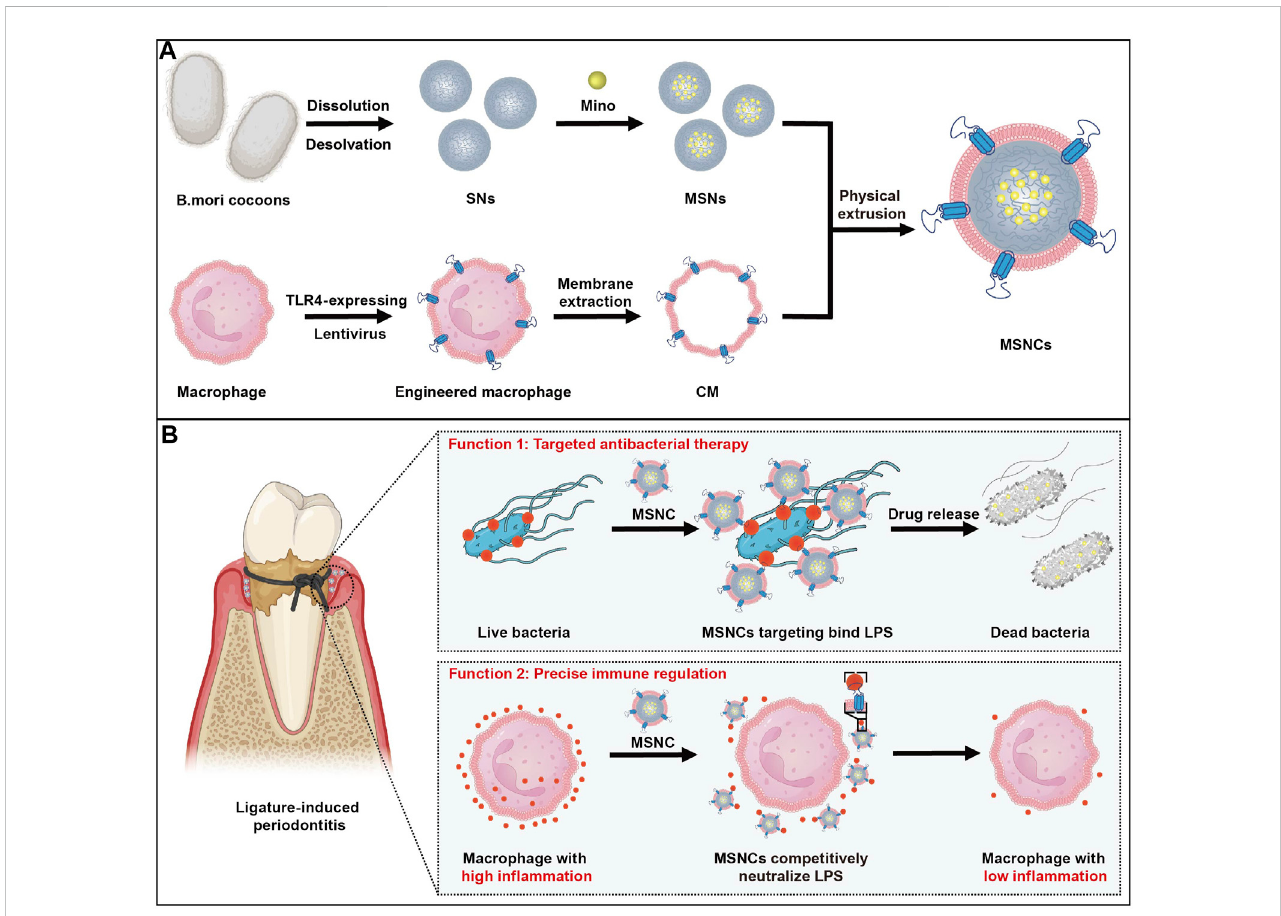
FIGURE 1 The fabrication and application of functioned cell membrane coated silk fi broin nanoparticles loaded with minocycline hydrochloride. (A) MSNCs are fabricated by coating engineered macrophage membranes onto SNs. (B) Application of MSNCs with targeted antimicrobial and precise immune regulation through topical administration of